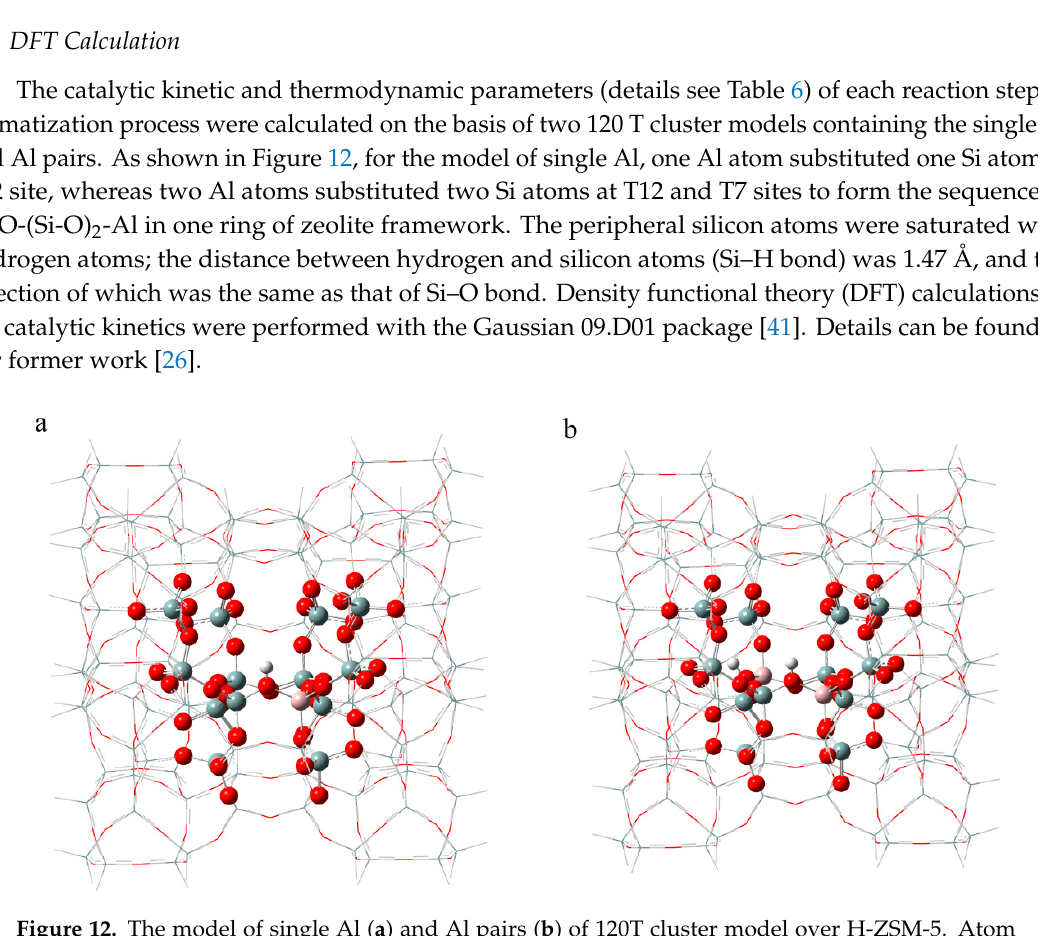
Figure 12. The model of single Al ( a ) and Al pairs ( b ) of 120T cluster model over H-ZSM-5. Atom coloring: gray (Si), red (O), white (H), and pink (Al).